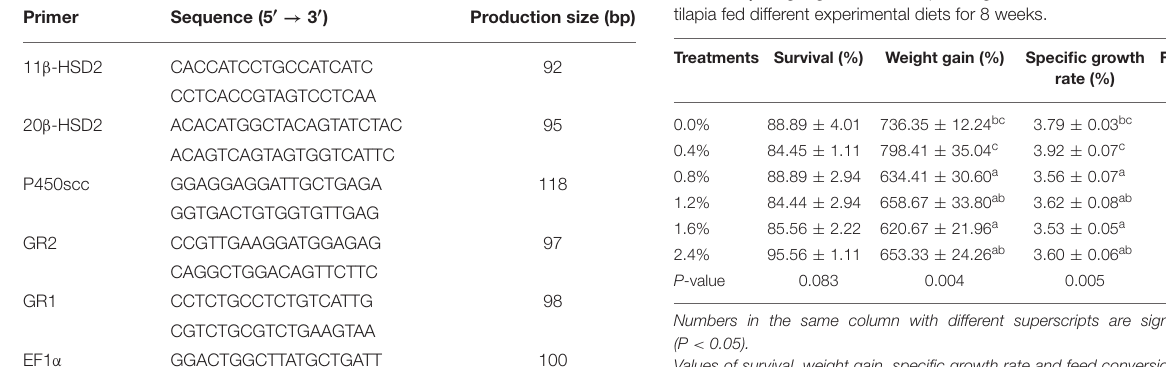
TABLE 3 | Weight gain, survival, specific growth rate, and feed coefficient of Nile tilapia fed different experimental diets for 8 weeks. Treatments Survival (%) Weight gain (%) Specific growth